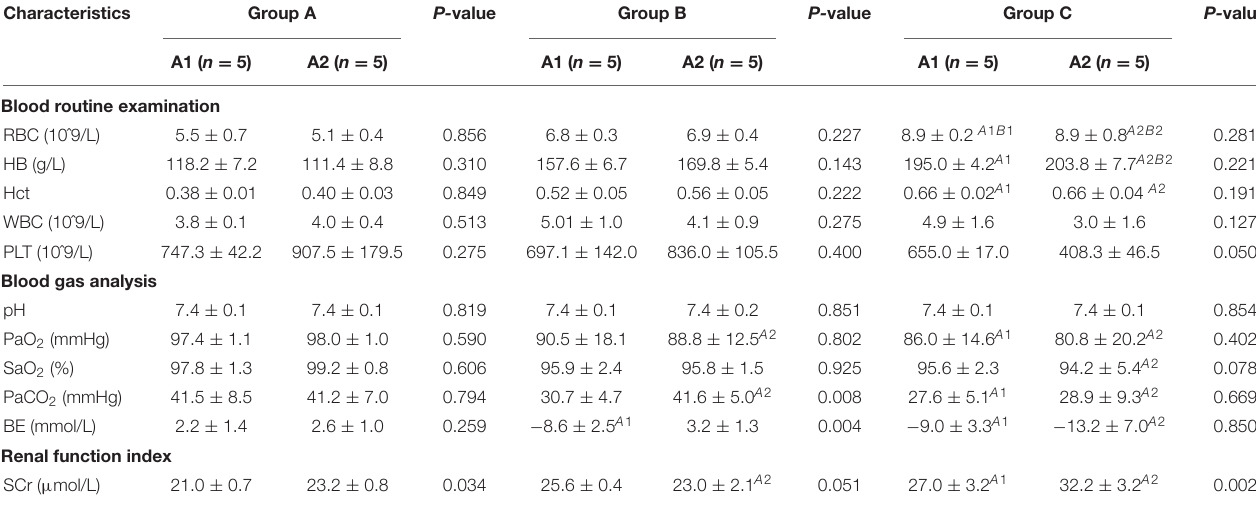
TABLE 1 | The results of blood analysis performed for rats of the three